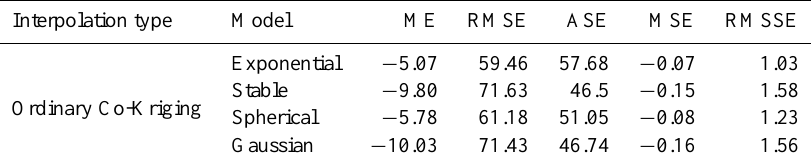
Table 3. Ordinary co-kriging models and cross validation results for Masika season, ME (mean error), RMSE (root mean square error),